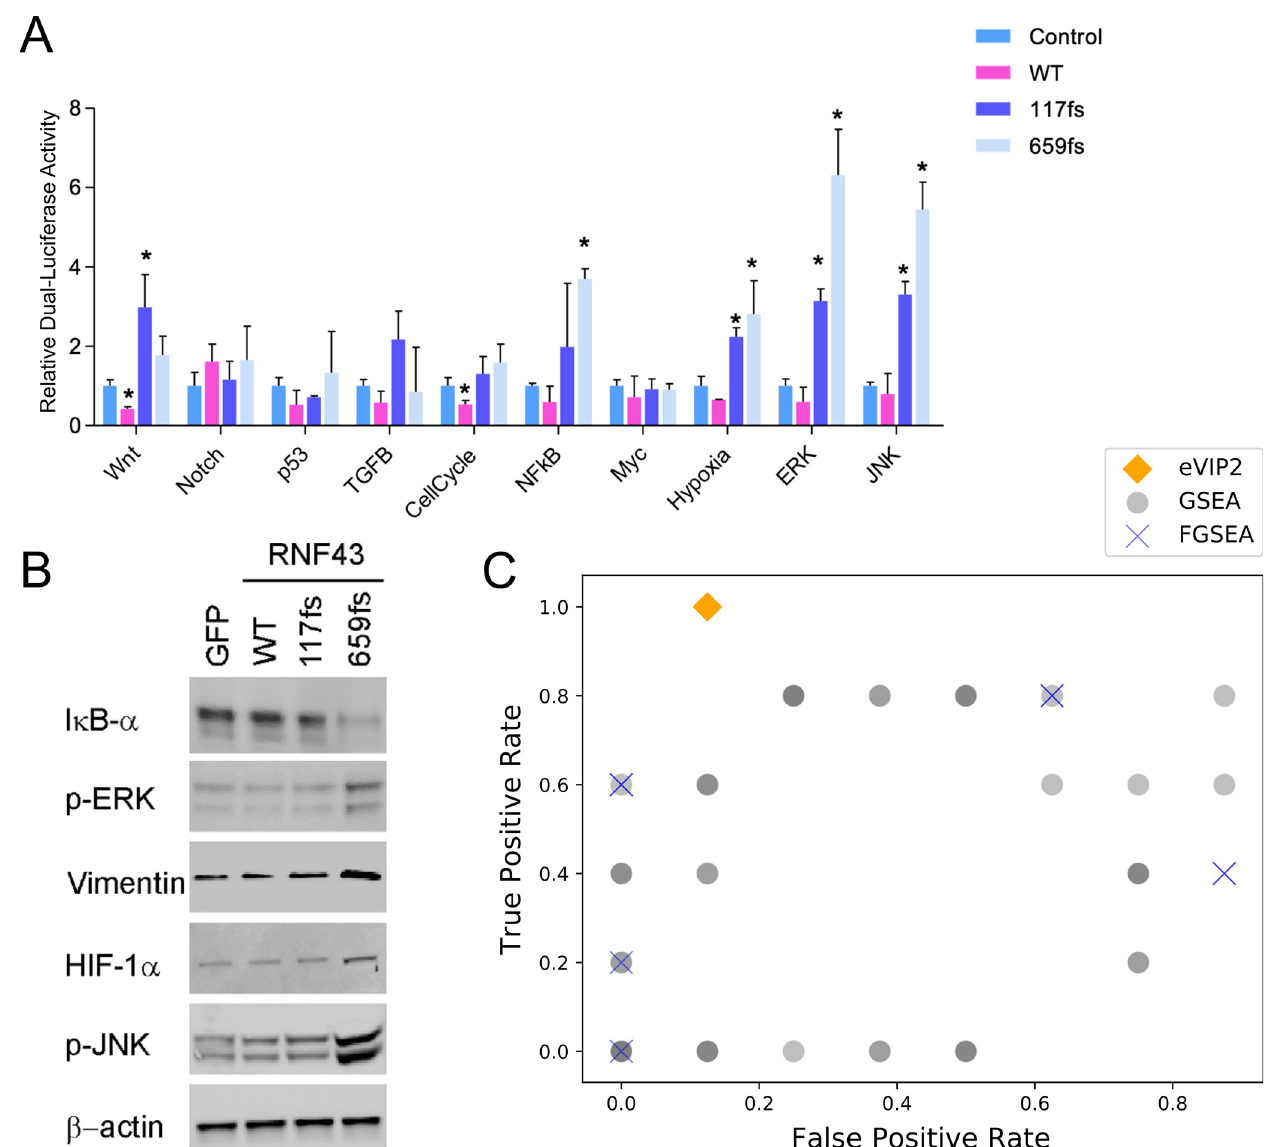
Fig 4. Validation of RNF43 G659fs pathway impact. (A) Cignal 10-Pathway Reporter Array data obtained in HEK-293T cells upon overexpression of Vector, RNF43-WT, RNF43-R117fs and RNF43-G659fs . Each bar represents the mean ± s.d. acquired from three independent experiments. A two-tailed Student’s t-test was used for statistical analysis ( � P < 0.05). (B) Western blot analysis upon overexpression of GFP, RNF43-WT, RNF43-R117fs, or RNF43-G659fs in HEK-293T of I κ B α , p-Erk, Vimentin, HIF-1 α and p-JNK. Anti- β -actin was used as a loading control (C) True positive rate (sensitivity) and false positive rate (1-specificity) across eVIP2, 80 variations of GSEA, and 8 variations of FGSEA.